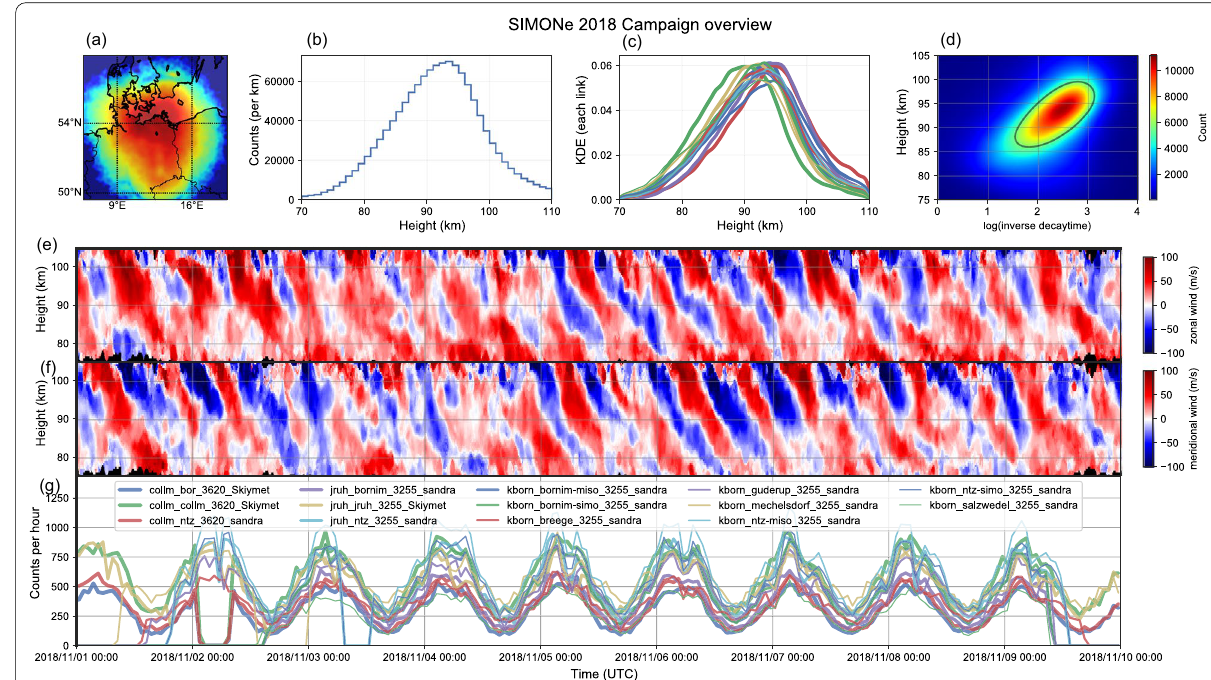
Fig. 1 Example of parameters obtained after combining the fourteen SIMONe 2018 links: a 2D histogram of detections on latitude vs longitude axes, b altitude distributions across all links, c altitude distribution of each link, d 2D histogram altitude vs inverse decay time, e mean zonal winds, f mean meridional winds, and g counts per hour for each bistatic